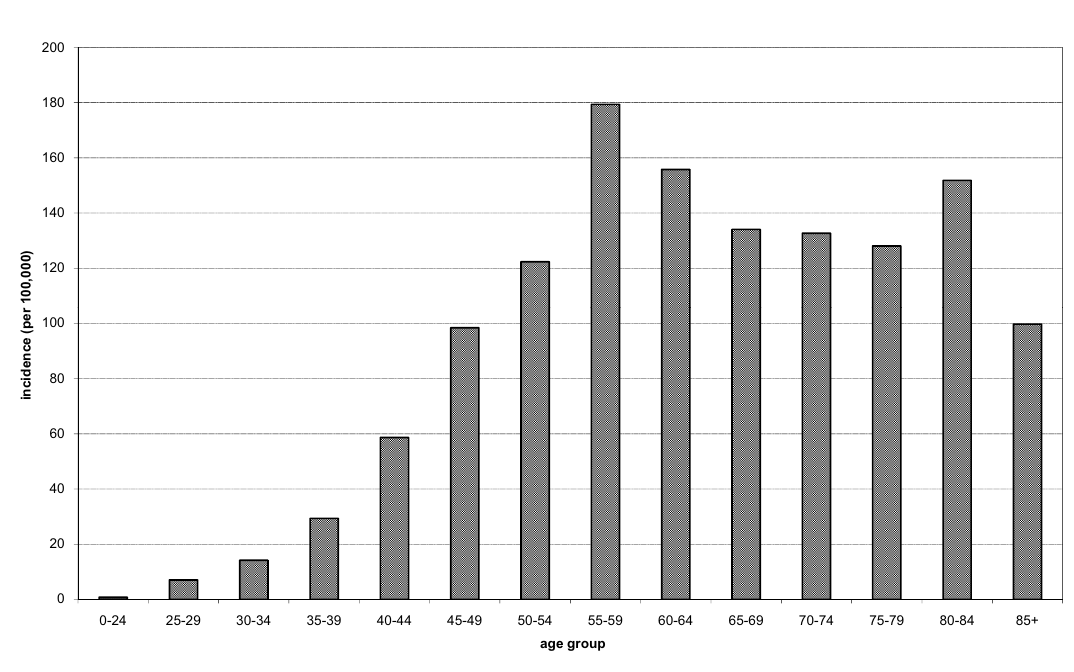
Fig. 3 The age-specific incidence of breast cancer in Lower Silesian women between 1984 and 2003.